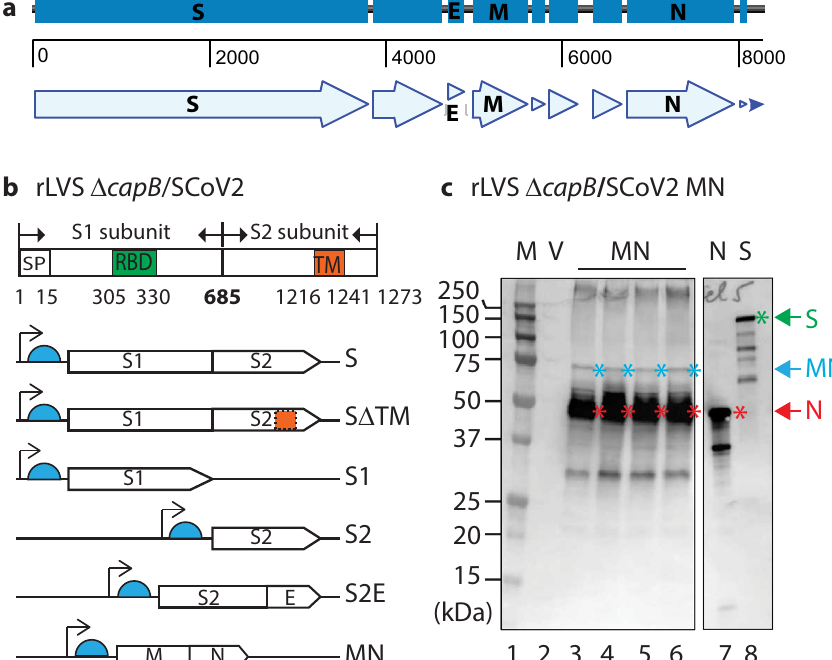
Fig. 1 Construction of rLVS Δ capB /SARS-CoV-2 vaccines. a Schematic of SARS-CoV-2 genomic region encoding four major structural proteins, Spike (S) glycoprotein, Envelope (E), Membrane (M), and Nucelocapsid (N) protein. b Diagram of S protein and the antigen expression cassettes for S, S Δ TM, S1, S2, fusion protein of S2 and E (S2E) and fusion protein of M and N (MN) downstream of the F. tularensis bacterioferritin (FTT1441) promoter (Pbfr) (thin black arrow) and Shine-Dalgarno sequence (light blue half circle). SP, signal peptide for S protein; RBD, receptor-binding domain; and TM, transmembrane domain. c Protein expression of rLVS Δ capB /SCoV2 MN. Total bacterial lysates of 4 clones of rLVS Δ capB /SCoV2 MN (lanes 3 – 6, as indicated at the bottom of the left panel) were analyzed by SDS-PAGE and Western blotting with an anti-SARS-CoV-1 guinea pig polyclonal antibody (BEI Resources, NR-10361), which readily detected the full-length MN (~75 kDa, less abundant), indicated by blue asterisks to the right of the protein bands, and the highly abundant breakdown product N protein (~46 kDa), indicated by red asterisks to the right of the protein bands. The anti-SARS-CoV-1 guinea pig polyclonal antibody also detected the N (red arrow and asterisk) and S (green arrow and asterisk) proteins of SARS-CoV-1 (lanes 7 and 8), which served as positive controls. V, LVS Δ capB vector (lane 2). The left and right panels are from the same gel (Supplementary Fig. 6). The sizes of the molecular weight markers (M) are labeled to the left of the